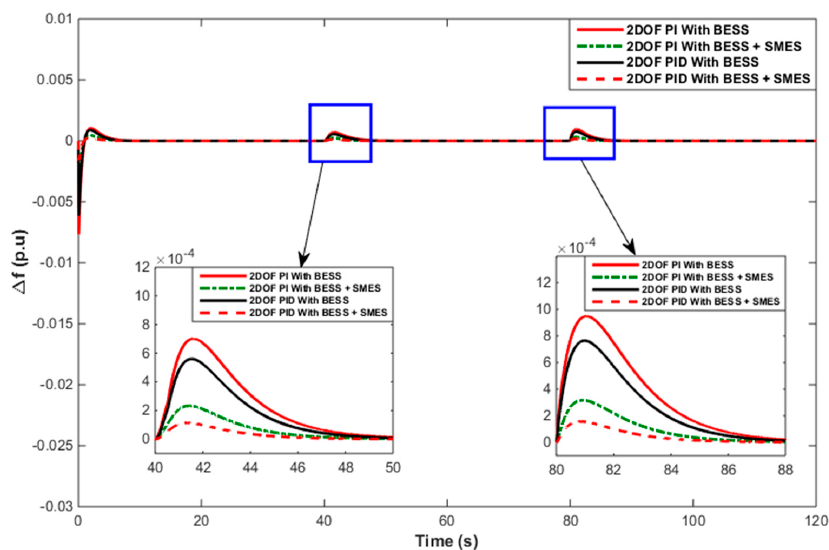
Figure 16. Comparative performances of the frequency responses of BESS (case 1) and BESS + SMES (case 3) with the FPA-optimized 2DOF-PI- and 2DOF-PID-controller-based hybrid energy systems.